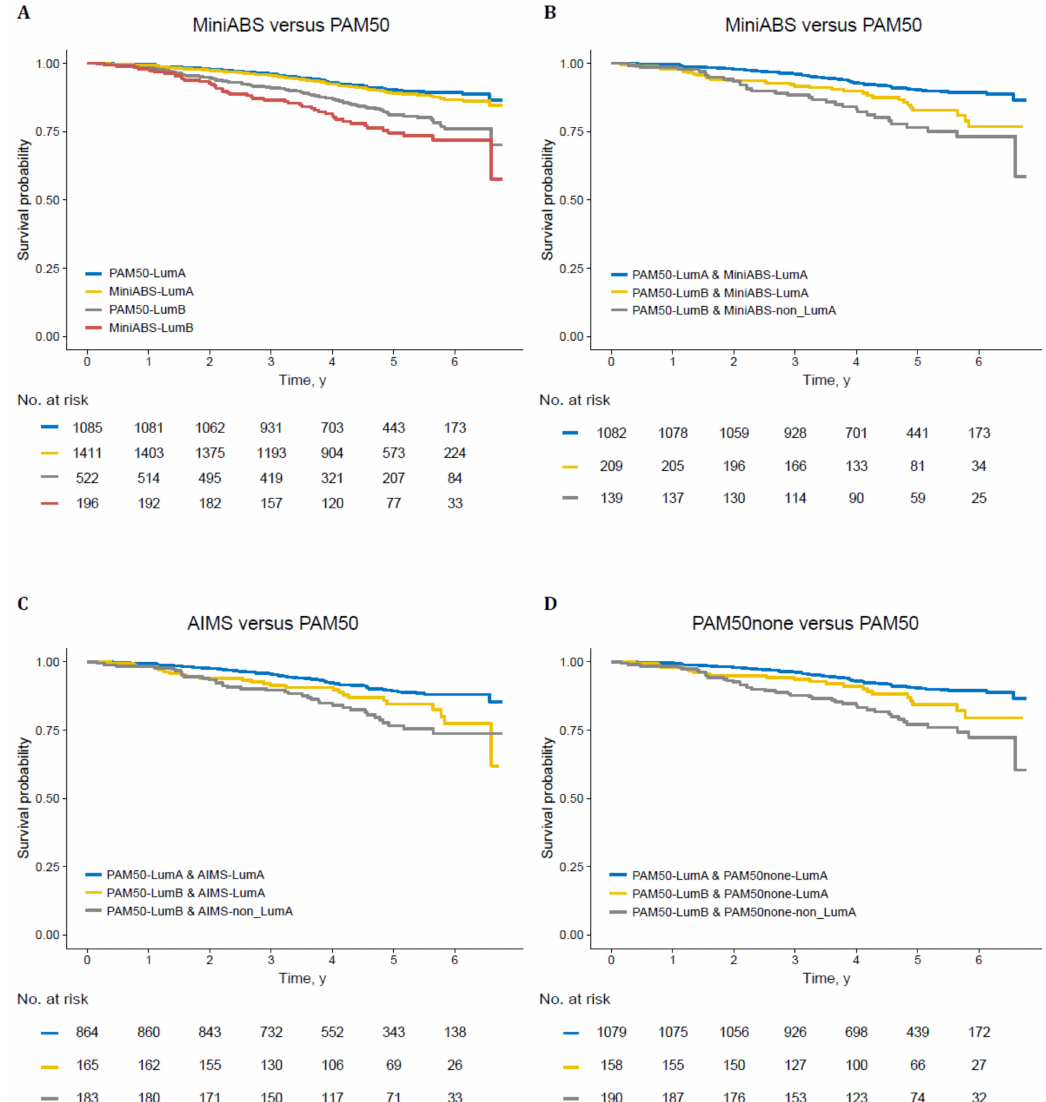
Figure 3. Kaplan–Meier survival analysis of patients treated by endocrine therapy. ( A ) Survival plot for LumA and non-LumA of MiniABS versus PAM50. Survival plot for PAM50 and ( B ) MiniABS; ( C ) AIMS; ( D ) PAM50none. PAM50none is a subtype of the sample identified by the genefu package using the “none”